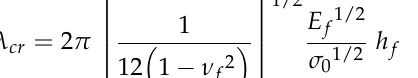
Figure 1. Schematic illustration of a compressed film on a viscous layer in a wrinkled state. The minimum stress required for buckling is defined as the critical compressive stress, and the wavelength of the corresponding wrinkle pattern is defined as the critical wavelength.